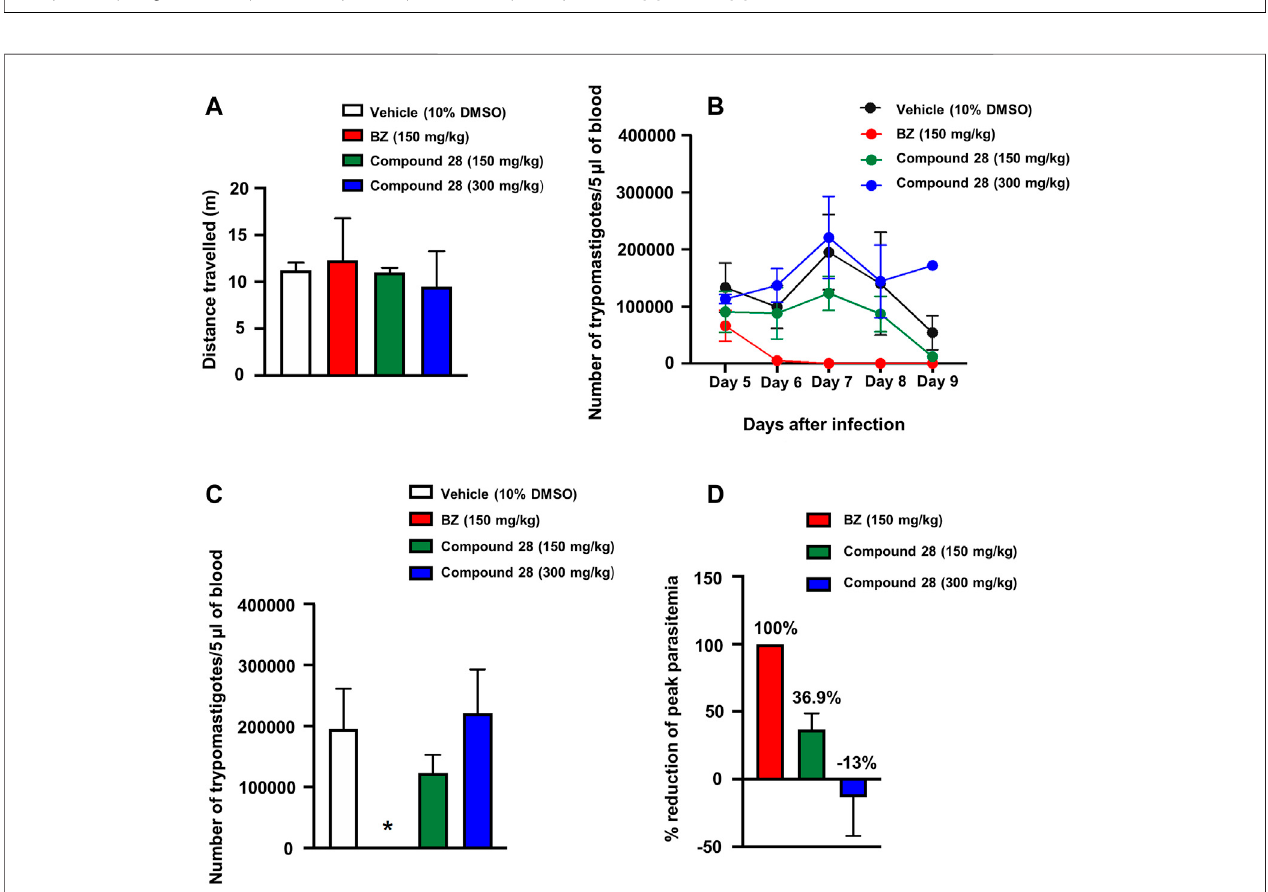
FIGURE 7 | Acute toxicity and trypanocidal activity in vivo . (A) Open- fi eld test. Mice were orally treated with vehicle (10% DMSO) or benznidazole (BZ) at doses of 150 mg/kg or 28 at doses of 150 and 300 mg/kg. (B) Parasitemia during T. cruzi infection in mice treated with vehicle, BZ or 28 (150 and 300 mg/kg) expressed as the number oftrypomastigotesper 5 μ lofblood. Thedata represent themean parasitemia ± SEM(4 – 8animals per group) forallassays. (C) Peak parasitemia expressed as thenumberoftrypomastigotesper5 μ lofbloodinmicetreatedwithvehicle,BZor 28 (150and300 mg/kg)(* p < 0.05whencomparedtovehicleandothergroups). (D) Reduction of peak parasitemia (seventh day of infection) in mice treated with vehicle, BZ or 28 (150 and 300 mg/kg). Vehicle solution: 0.9% NaCl + 10% DMSO.